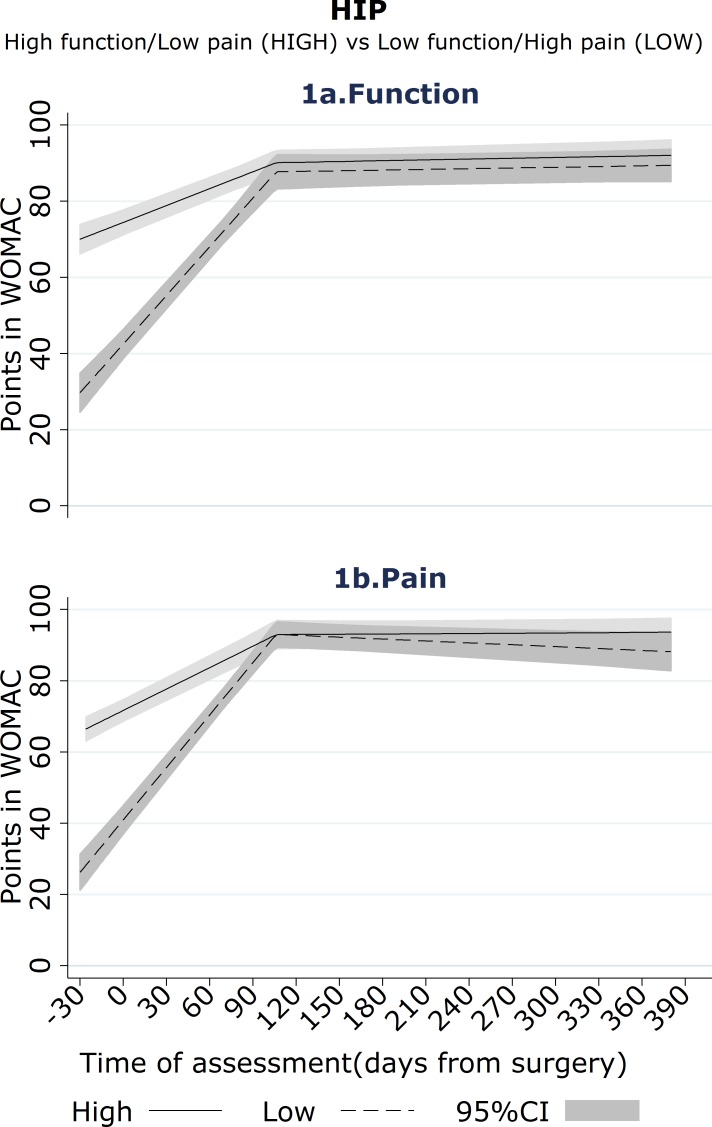
Hip-Mean trajectoriesa for WOMAC-pain and WOMAC-function (Unstandardised outcomes) by high vs. low pre-operative pain/functionb.A. The mean trajectories are derived from the fixed effects of linear mixed model stratified on high-low profile and regressing each outcome on the time of assessment parameterised as two linear splines. B. High/low function status defined on pre-operative WOMAC-function or -pain using their median scores (54 and 55) as cut-points.